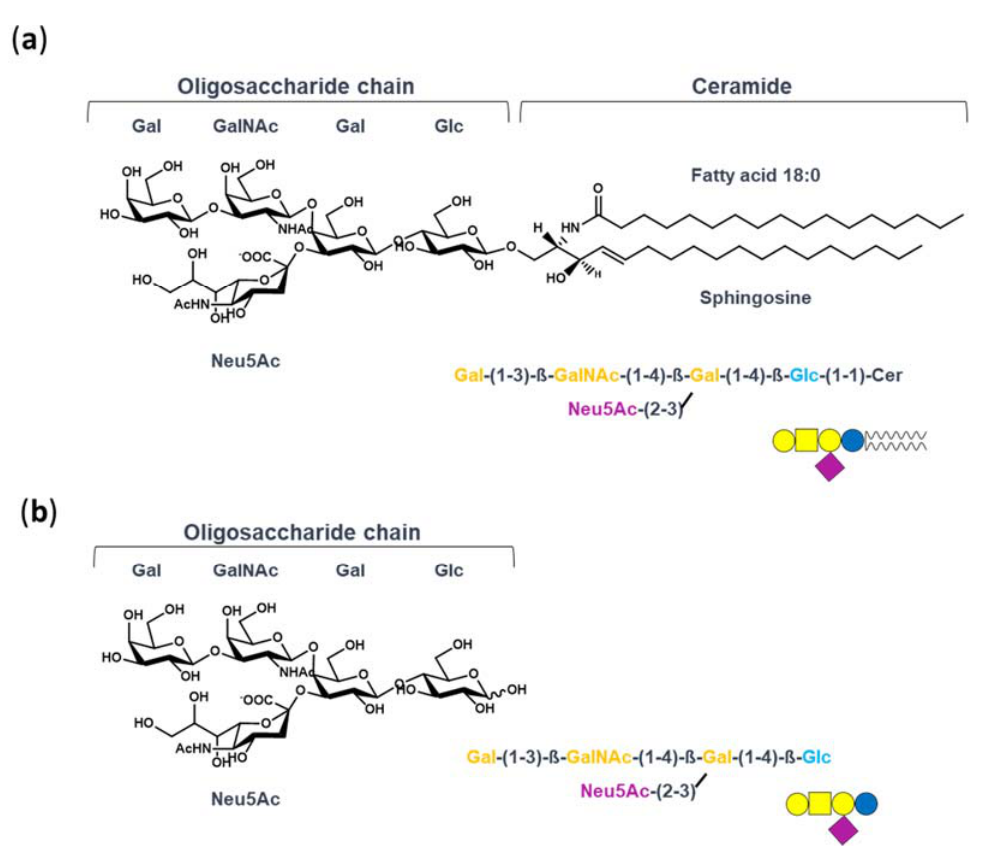
Figure 1. Structure of GM1 and OligoGM1: ( a ) ganglioside GM1, II 3 Neu5AcGg 4 Cer; ( b ) GM1-oligosaccharide chain, II 3 Neu5AcGg 4 . The GM1 sugar code is according to Varki et al. [30].